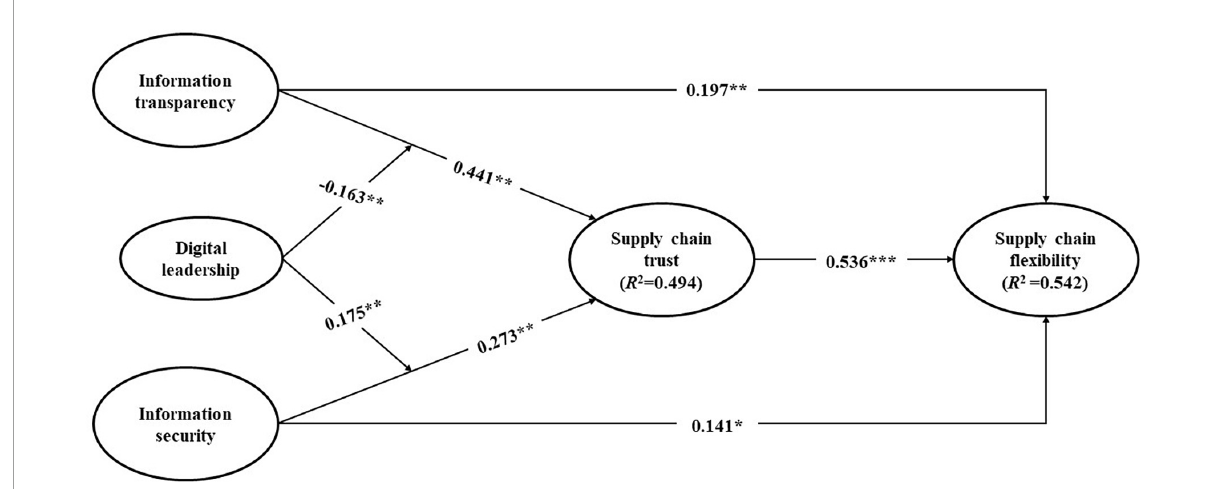
FIGURE1 Conceptual